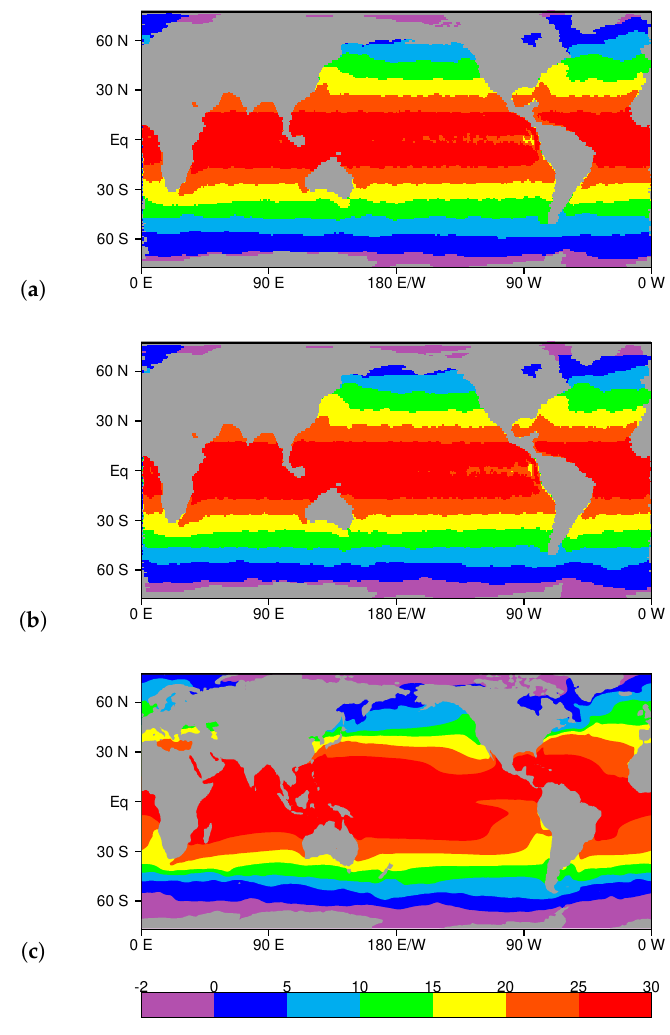
Figure 7. Sea surface temperature ( ◦ C). ( a ) Simulation with mixing. ( b ) Simulation without mixing. ( c )